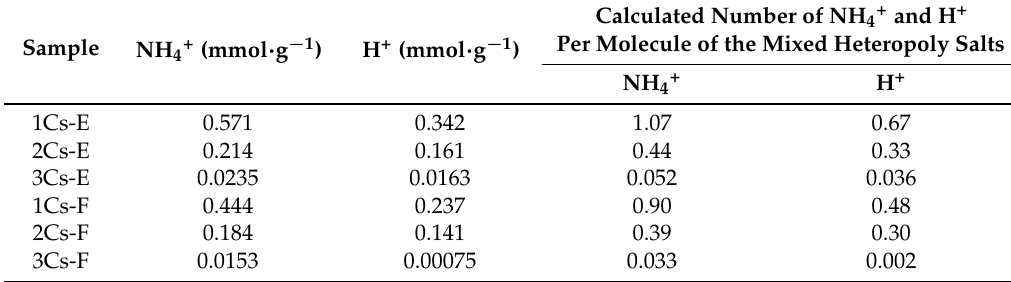
Table 2. The contents of NH 4+ and H + in the compounds calculated from NH 3 -TPD.